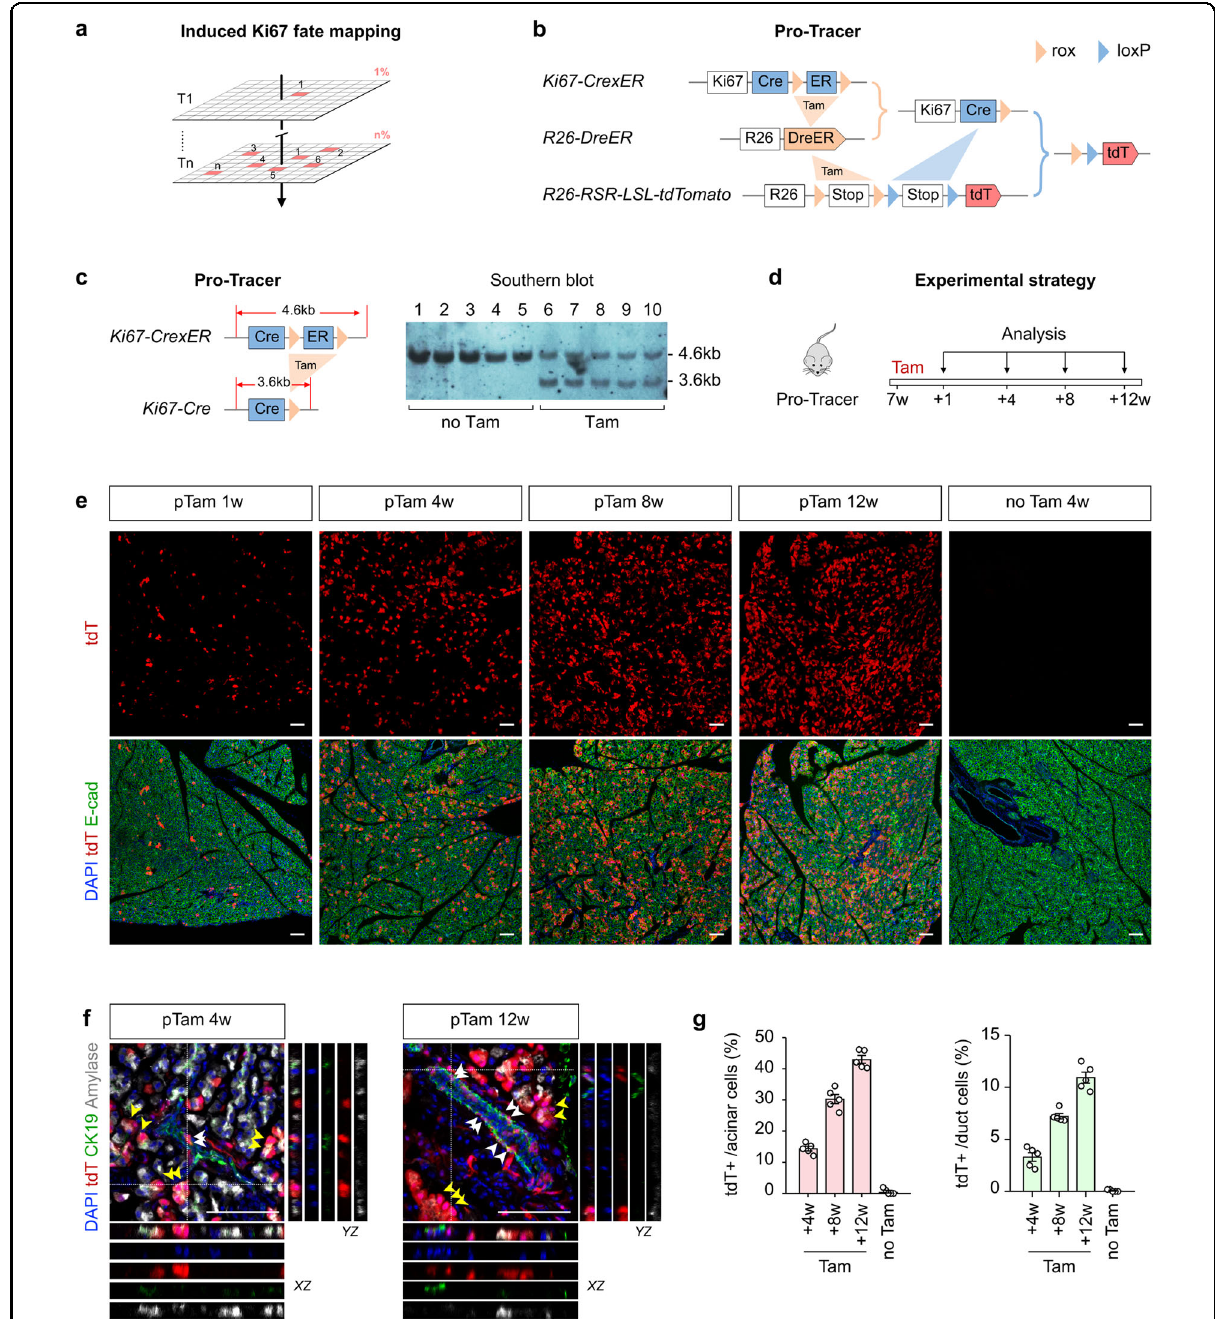
Fig. 3 Genetic tracing of pancreatic acinar and duct cell proliferation during physiology using ProTracer system reveals cellular turnover dynamics. a Schematic diagram illustrating the recording of Ki67 + cells (tdT) from Time 1 (T1) to Time n (Tn) in pancreas. Each red square denotes a Ki67 -expressing cell and progeny. b Schematic diagram illustrating the strategy for seamless recording of cell proliferation using ProTracer system. Tam-induced Dre/rox recombination switches Ki67-CrexER into Ki67-Cre , thus primes the mice to seamlessly record cell proliferation events. c Schematic diagram illustrating the strategy to detect fl oxed ER DNA excision in pancreas using Southern blotting of pancreatic DNA from Tam- or corn oil-treated (no Tam) ProTracer mice. d Schematic diagram illustrating the experimental strategy for Tam injection and post-treatment analysis. e , f Immunostaining for tdT and E-cad ( e ) or CK19 and Amylase ( f ) on pancreatic sections prepared from the indicated ProTracer mice. White arrowheads, tdT + duct cells. Yellow arrowheads, tdT + acinar cells. g Quanti fi cation of the percentage of duct and acinar cells expressing tdT by ProTracer mice from the indicated time points. Data are means ± SEM; n = 5. Scale bars, 100 μ m. Each image is representative of 5 individual